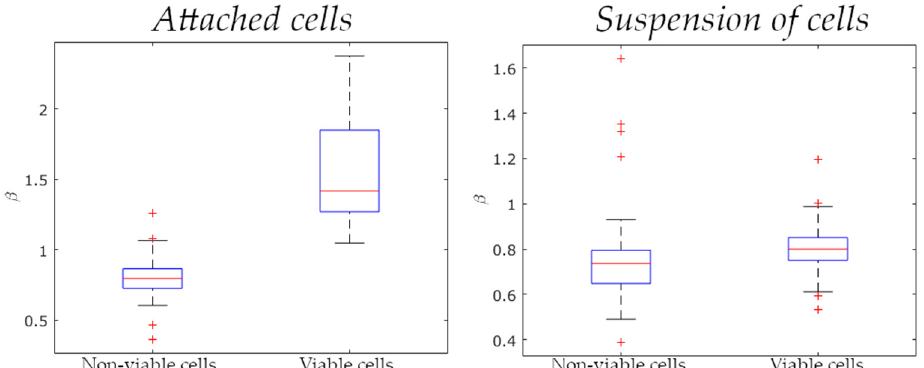
Figure 7. Power spectrum slopes of optical thickness fluctuations for the attached and suspended viable and non-viable MCF-7 cells ( p < 0.001). In each box, the central mark denotes the median, and the bottom and top sides of the box denote the 25th and 75th percentiles, respectively. The whiskers extend to the most extreme points not considered as outliers, with the outliers plotted individually using the “+” symbol.